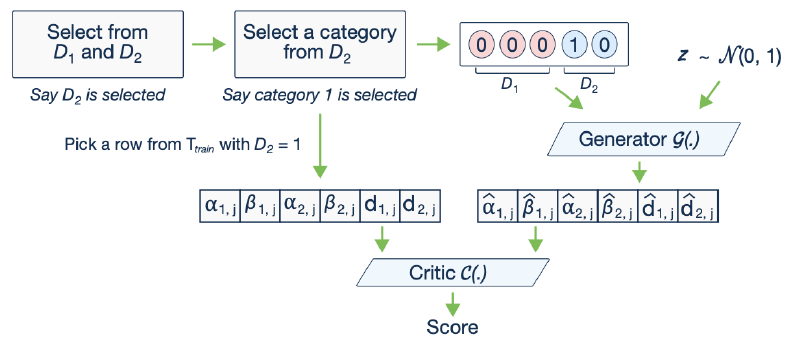
Figure 18. Diagram of a CTGAN. Image taken from